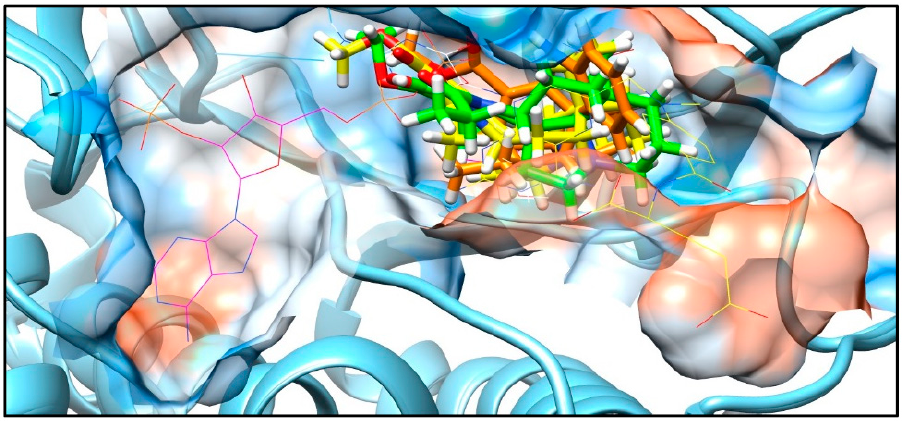
Figure A5. 3D molecular interaction of the complex PTR1 (1E7W) with NADP, MTX and THB represented by wire representations; APC ( yellow ), APA ( green ) and TBT ( orange ) by stick representations; and the protein surface represented by blue for the more hydrophilic, and white (neutral), orange and red for the more lipophilic regions.